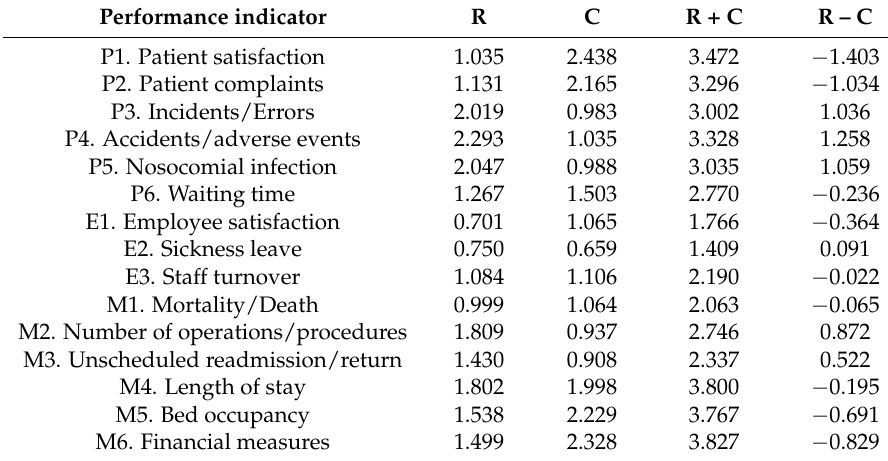
Table 6. Sum of influences given and received for each performance indicator.